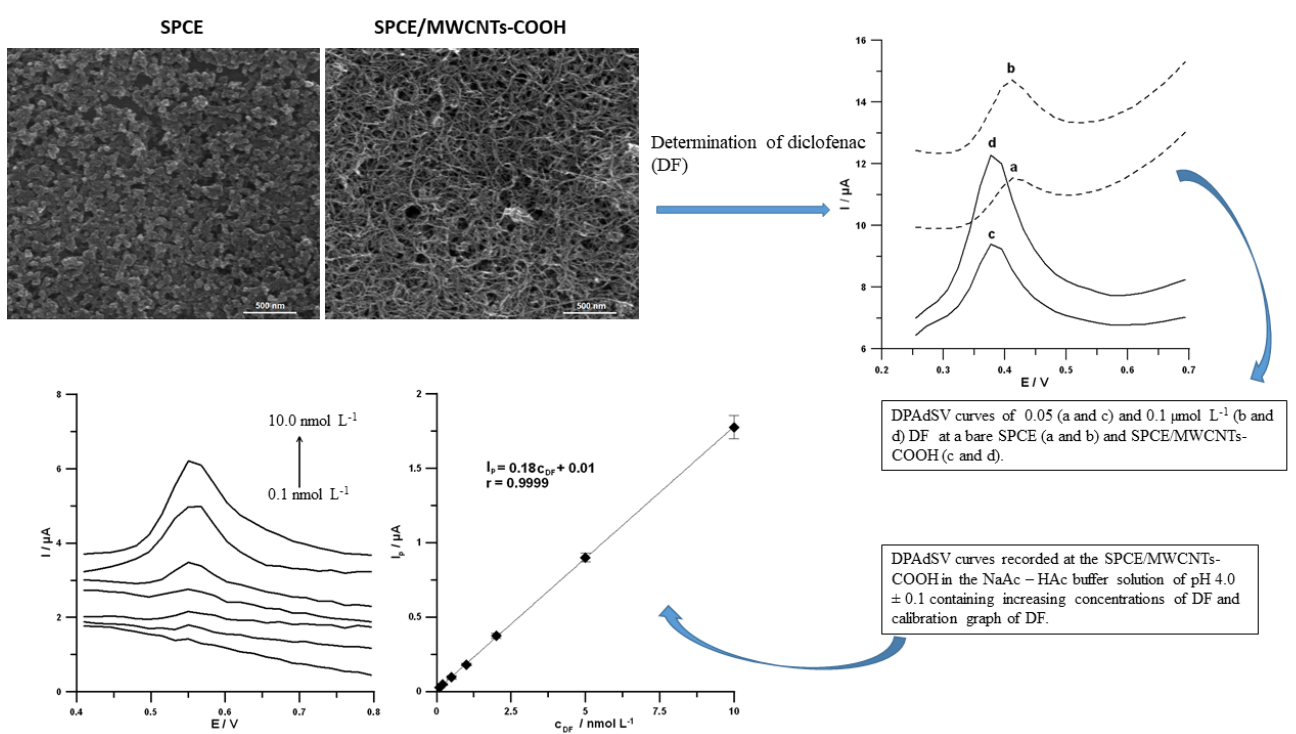
Figure 3. SEM images and DPAdSV curves recorded at the SPCE and SPCE/MWCNTs-COOH. DPAdSV curves recorded at the surface of the SPCE/MWCNTs-COOH in solution containing in- creasing concentrations of DF: 0.1, 0.2, 0.5, 1.0, 2.0, 5.0, and 10.0 nmol L − 1 , and calibration graph of DF [102].